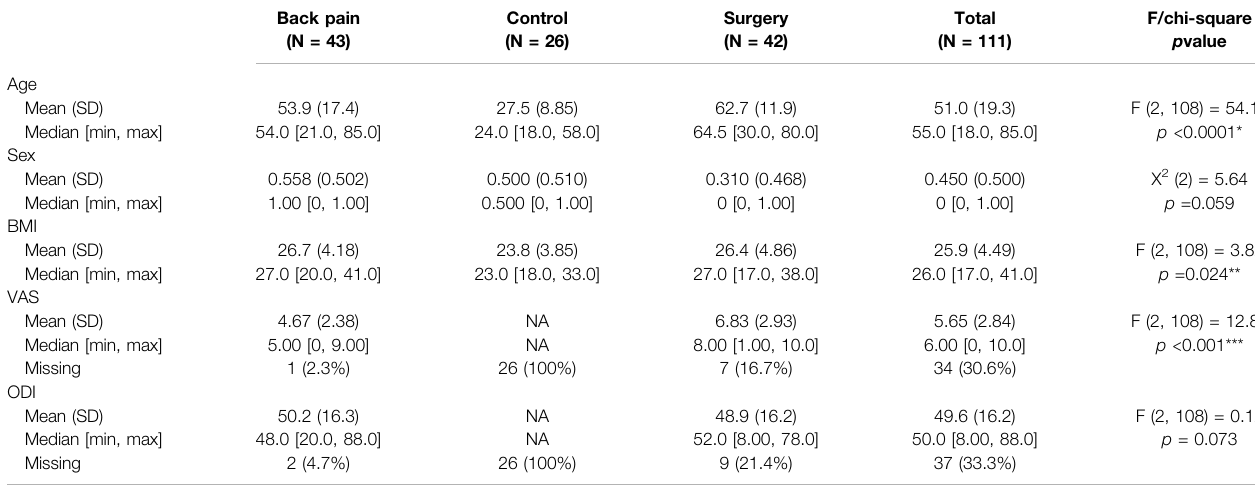
TABLE 1 | Participant